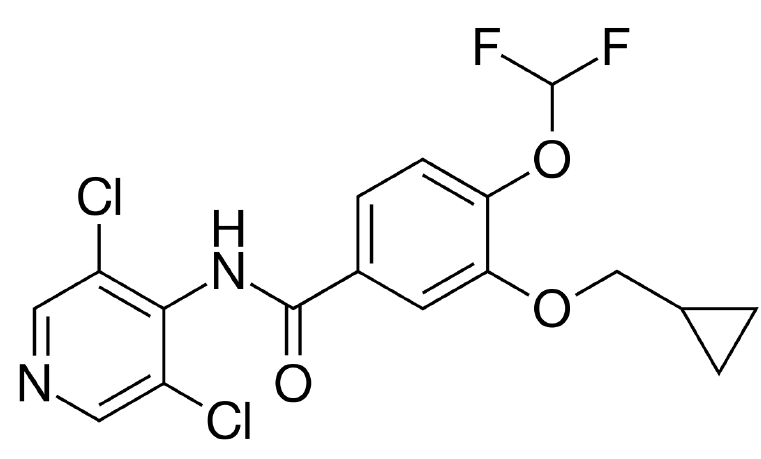
Figure 1. Structure of Roflumilast.